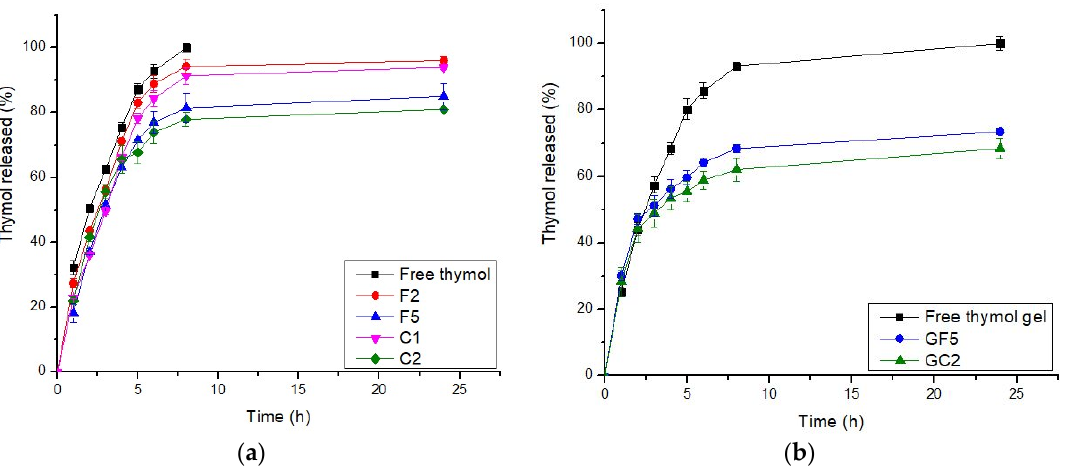
Figure 1. In Vitro release profiles of thymol from ( a ) thymol-loaded CPNPs and ( b ): thymol-loaded CPNP hydrogels (GF5 and GC2). (n = 3).